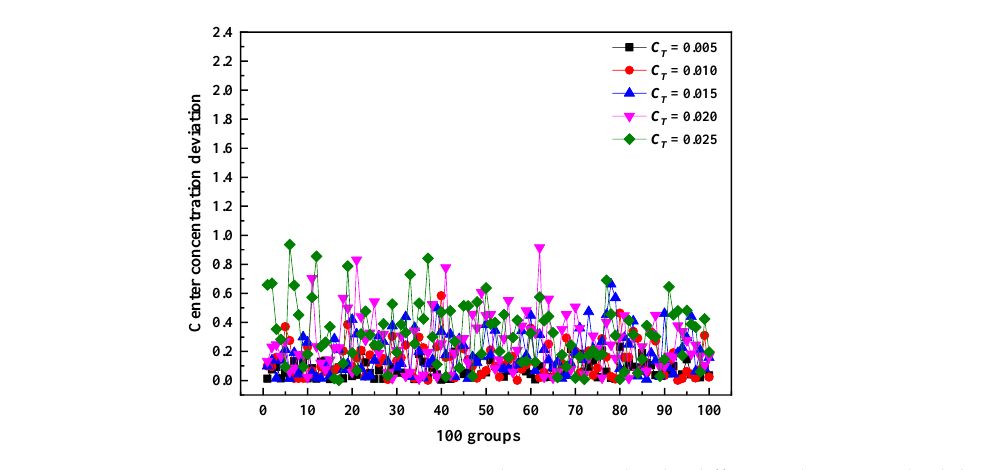
Figure 15. Center concentration deviation under the different relative standard deviations of temperatures at velocity 3.2 m/s.